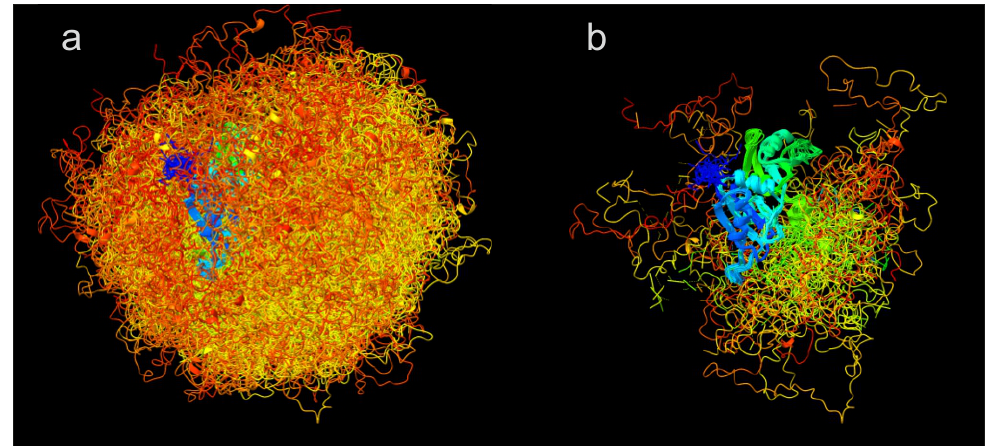
Figure 8. Effect of distance distribution restraints in ensemble reweighting. Shown are the raw ensemble ( a ) consisting of 1119 conformers for the RNA-binding protein hnRNP A1 in its free, dispersed form ([18]) and the reweighted ensemble ( b ) of 138 conformers from integrating information from 19 DEER distance distribution restraints and a SAXS curve ([21]). Visualization was performed by